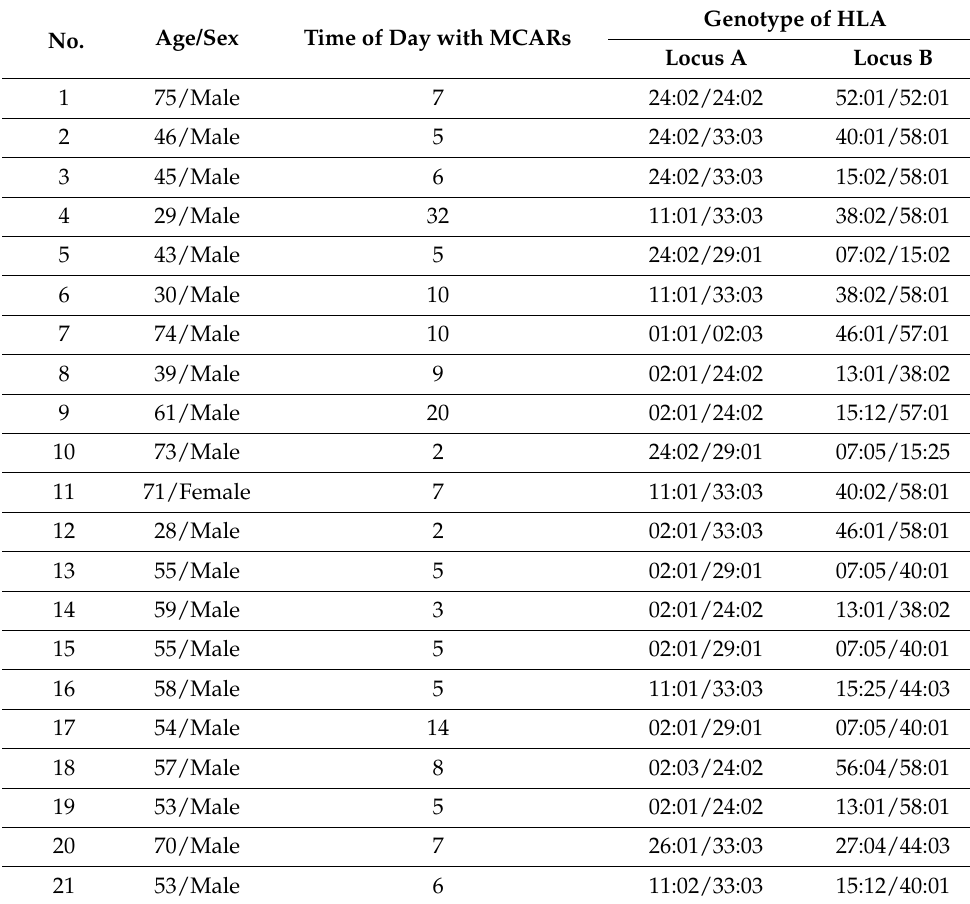
Table 2. Patients with ALP-induced MCAR gout with the onset time of ADR and the corresponding genotypes of the HLA